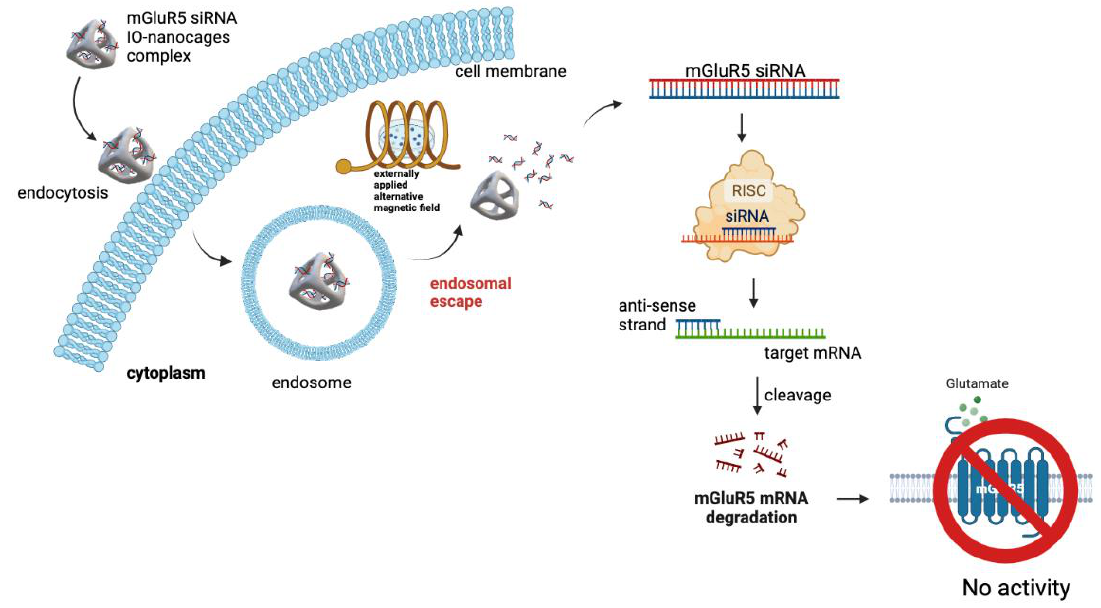
Figure 6. Schematic image of mGluR5 siRNA delivery system by using IO-nanocages in the presence of AMFs application. When mGluR5 siRNA releases in the cytoplasm after AMFs treatment, it will integrate with RNA-induced silencing complex (RISC) to undergo strand separation. Single strand within the complex will find its complementary mRNA, which result in mRNA degradation and prevent protein translation.